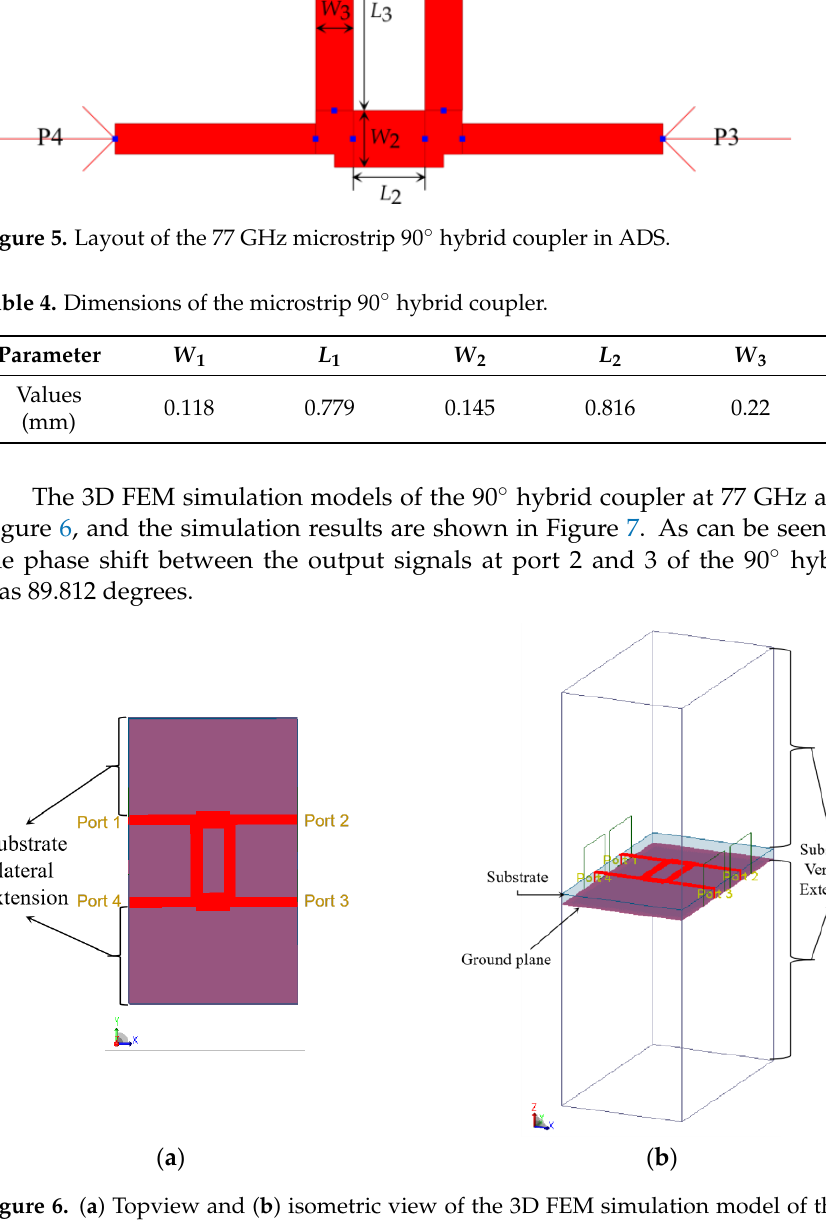
Figure 6. ( a ) Topview and ( b ) isometric view of the 3D FEM simulation model of the 90° hybrid coupler in ADS.